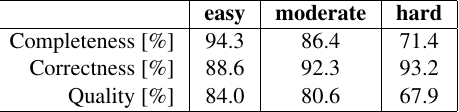
Table 2. Vehicle detection results.